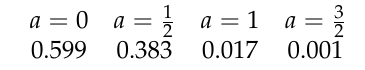
Table 1. Probabilities for ( k = 3 ) anyon excitations ( a , a ) in the ( ˜k = 2 ) -vacuum